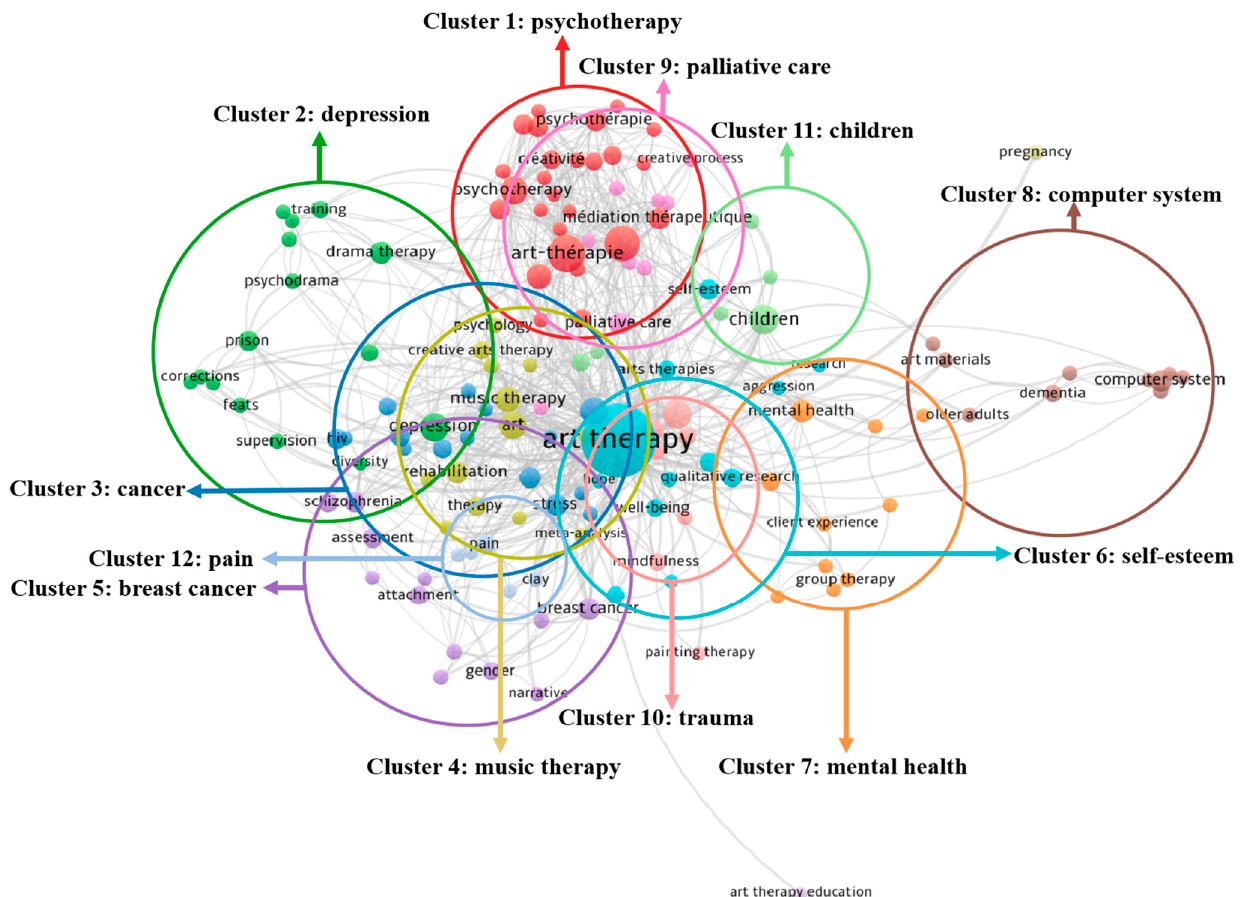
Figure 7. Twelve clusters of AT themes in the Network Visualization diagram generated by VOSviewer (devised by the authors).